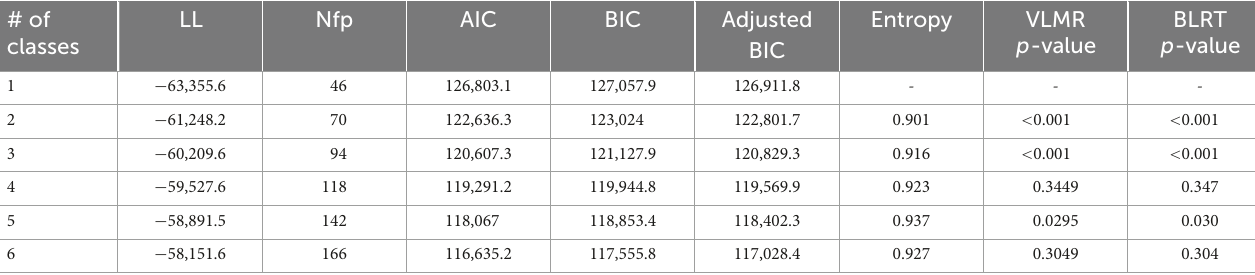
TABLE 2 Latent profile analysis fit statistics across models.